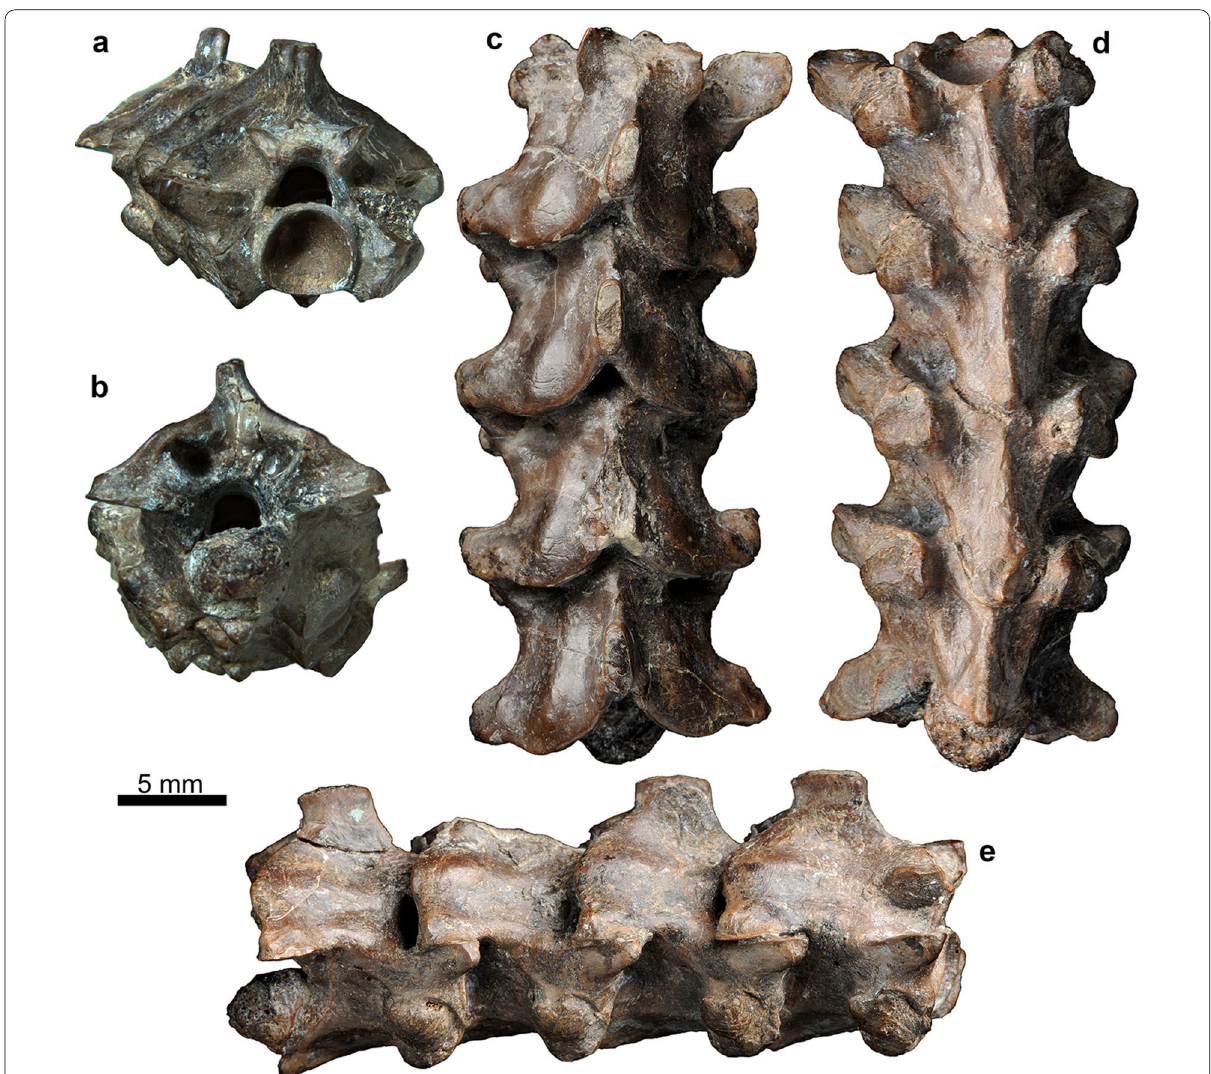
Fig. 48 Eoconstrictor fischeri from Messel, holotype (part) (SMF-ME 929): string of four articulated vertebrae in anterior ( a ), posterior ( b ), dorsal ( c ), ventral ( d ), and right lateral ( e ) views. This string was originally closely connected with the other part of the holotype, string of Fig. 50, of which it was placed more